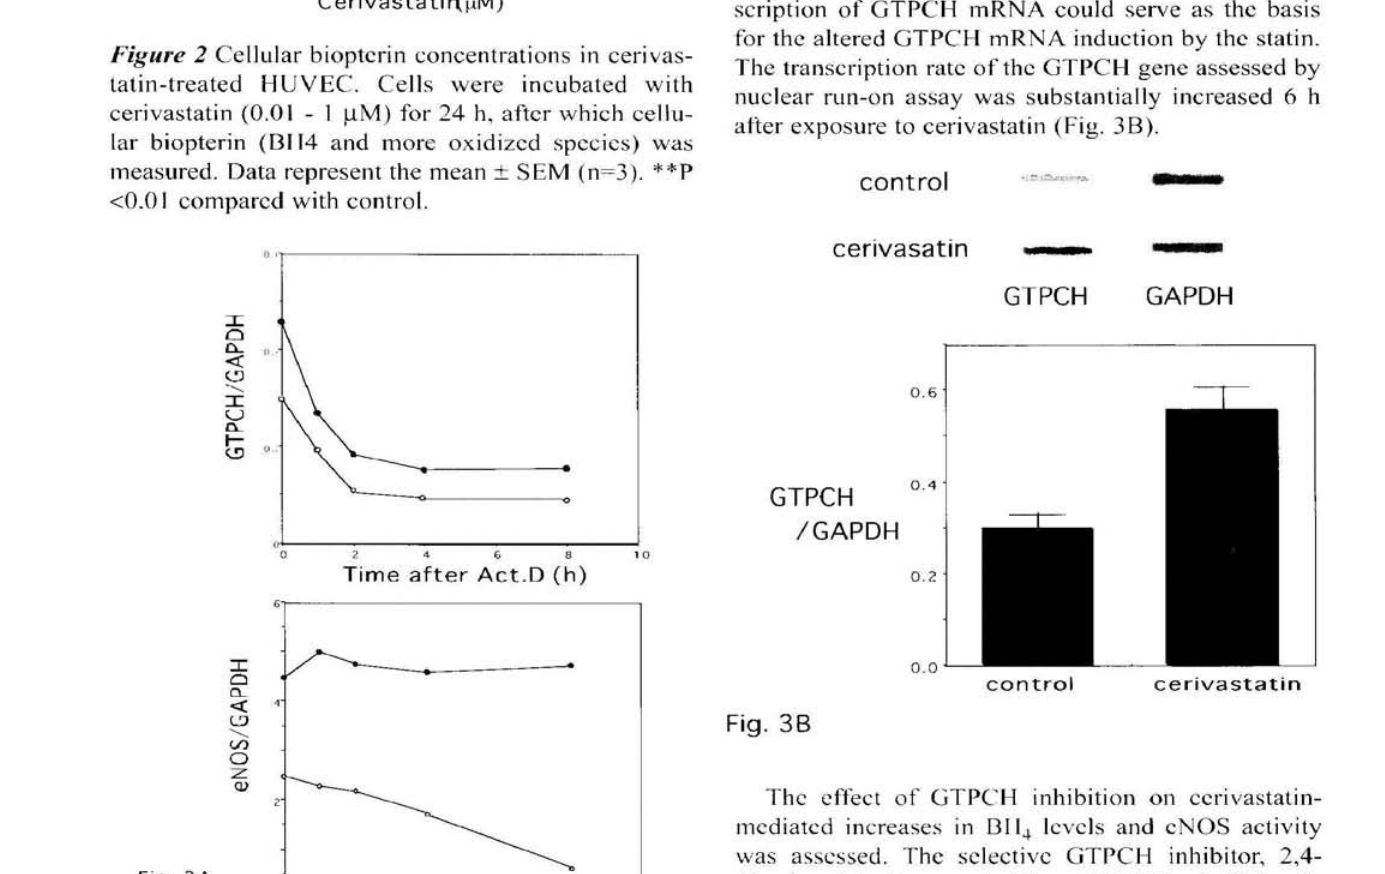
Fig. 3A Time after A c t .D (h) Figure 3 ( A) Effect of cerivastatin on GTPCH and eNOS mRNA stability. Cells were exposed to actino- mycin D (Act.D; 5 μg/ml) in the absence (open cir- cles), or presence (closed circlcs), of cerivastatin (0.5 μΜ). After the indicated lime periods, mRNA levels were measured by Realtime PCR. Data represent